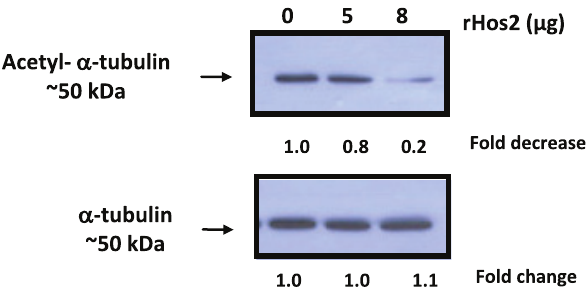
Figure 4. Deacetylation assays of rHos2 with α tubulin. α -tubulin acetylation determined by Western blot of SAHA-treated whole cell extracts containing acetylated α -tubulin (10 μg) incubated with 0, 5 or 8 μg of recombinant Hos2 for 3 hrs at 37°C in HDAC assay buffer.